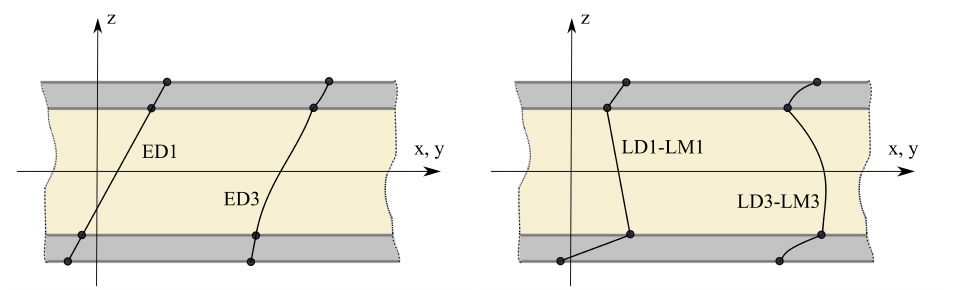
Figure 2. Linear and cubic ESL and LW